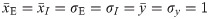
Critical capacity and weight balance.A: Average loss ϵ for a linear perceptron with fE = 0.8 positive synaptic weights in the case of i.i.d. input X and output y for increasing values of the regularization γ. Parameters: N = 1000, x¯E=x¯I=σE=σI=y¯=σy=1. Each point is an average across 50 samples. Full lines show the theoretical results. B: Mean-field component h˜ (left axis, purple) and weight-input correlation c (right axis, red) for increasing dimension N in the case where the bias current b=IN is either learned (I optimal) or fixed at the outset (I = −1) for fE = 1, γ = 0.1, α = 0.8. Inputs X and output y are time-correlated with un-normalized Gaussian covariance C, τ = 10 (see text). The remaining parameters are as in A. The asymptotic value h˜=y¯=1 is highlighted by the purple dotted line, the value c = 0 by the red dotted line as guide for the eye.